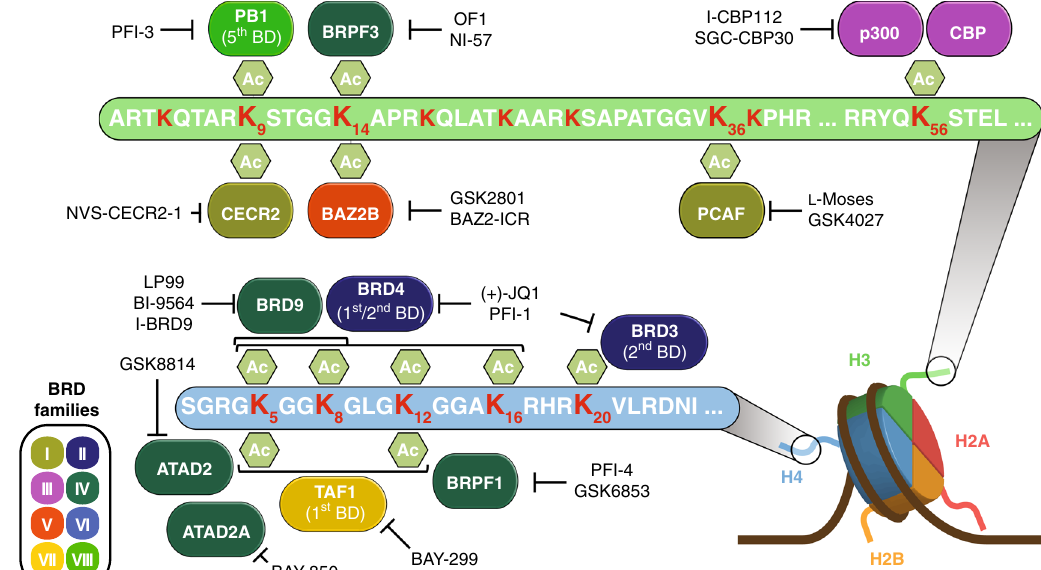
Fig. 2 Schematic representation of interaction sites of current set of bromodomain (BRD) chemical probes. Major sites of lysine acetylation on histone H3 and H4 are highlighted in